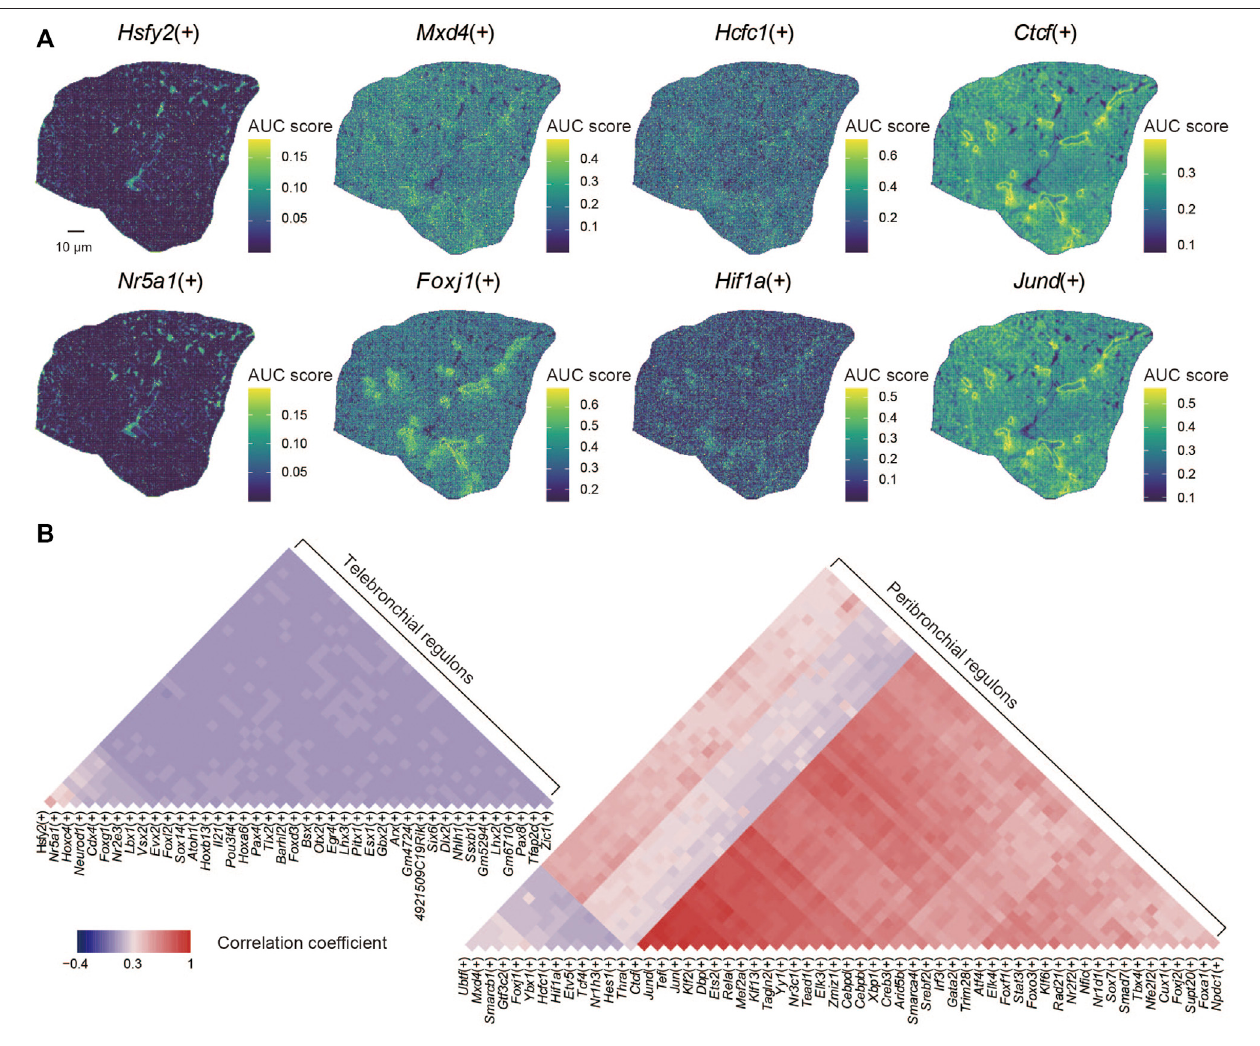
FIGURE3| Spatialcharacteristicsofregulons inthelung. (A) Spatial distribution ofregulons: Hsfy2 (+), Nr5a1 (+), Mxd4 (+), Foxj1 (+), Hcfc1 (+), Hif1a (+), Ctcf (+),and Jund (+). (B) The correlation coef fi cient of the spatial distribution of regulons.